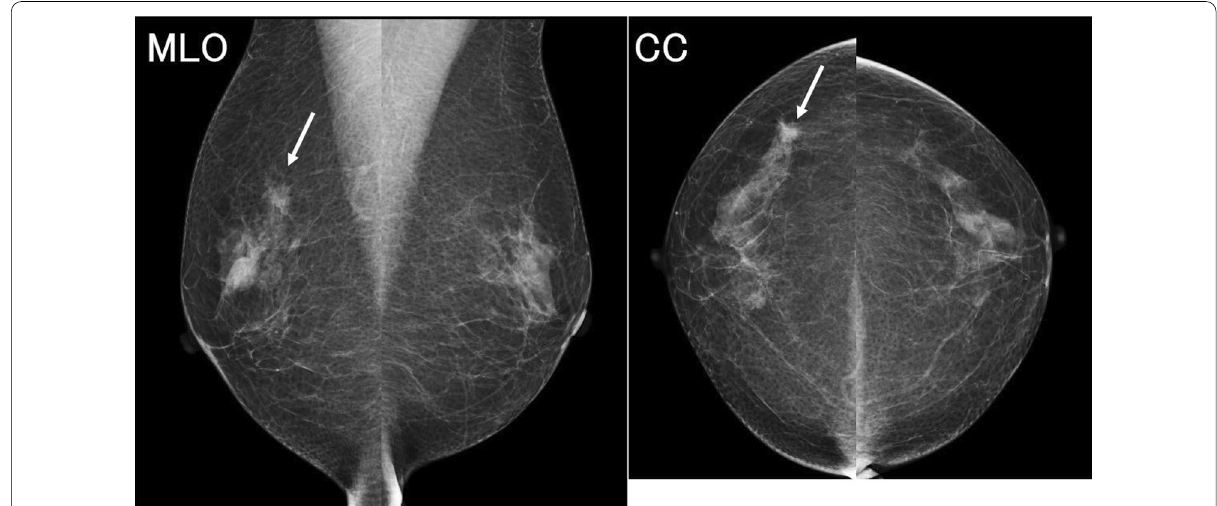
Fig. 1 Mammogram findings. Right mediolateral oblique (MLO) and craniocaudal (CC) views of mammograms show focal asymmetric density (arrows)